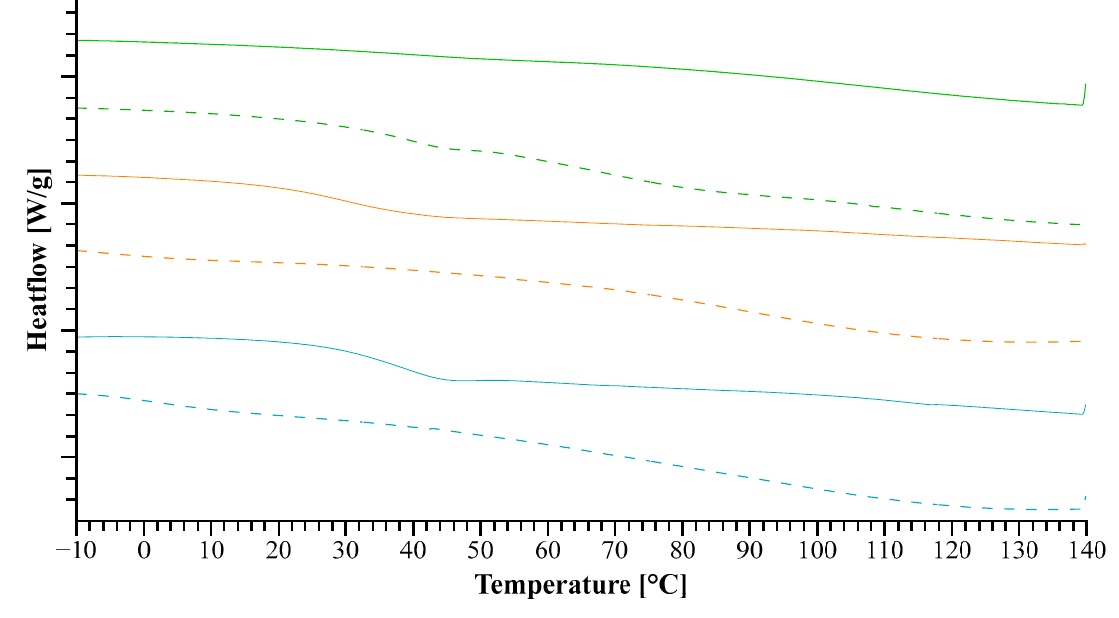
Figure 1. The solid lines represent the differential scanning calorimetry (DSC) thermograms of the extrudates and the dotted lines represent the evaporates which were used for the later extrusion. The amino acids added to sodium carboxymethylcellulose (NaCMC) are arginine (cyan), lysine (orange), and histidine (green).